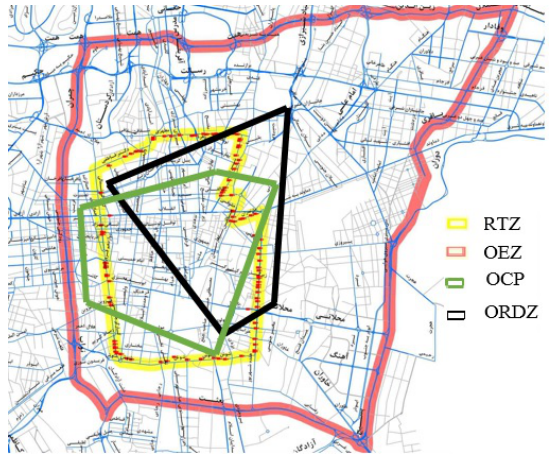
Figure 15. Restricted traffic zone of ORDZ, OCP, RTZ, OEZ